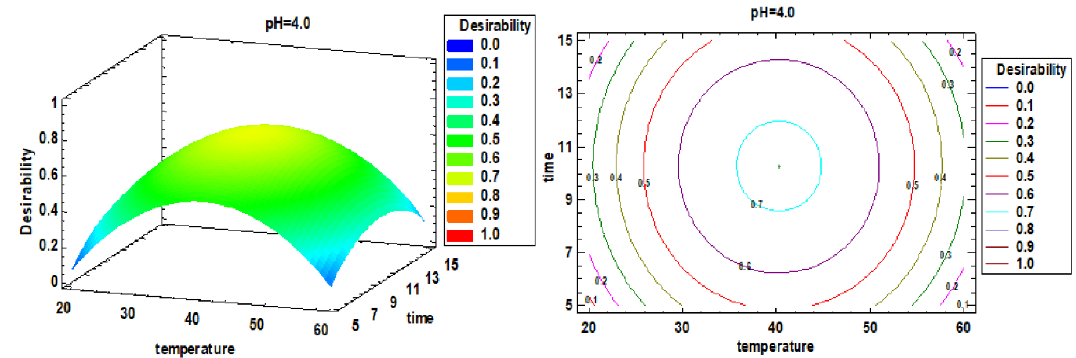
Figure 4. Estimated response surface and contour plots for multiple factor responses.